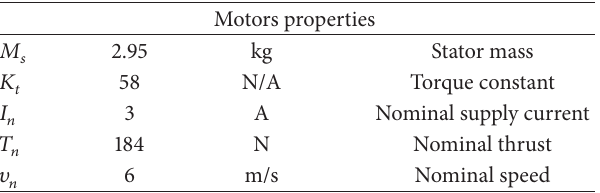
Table 2: Parameters of the linear